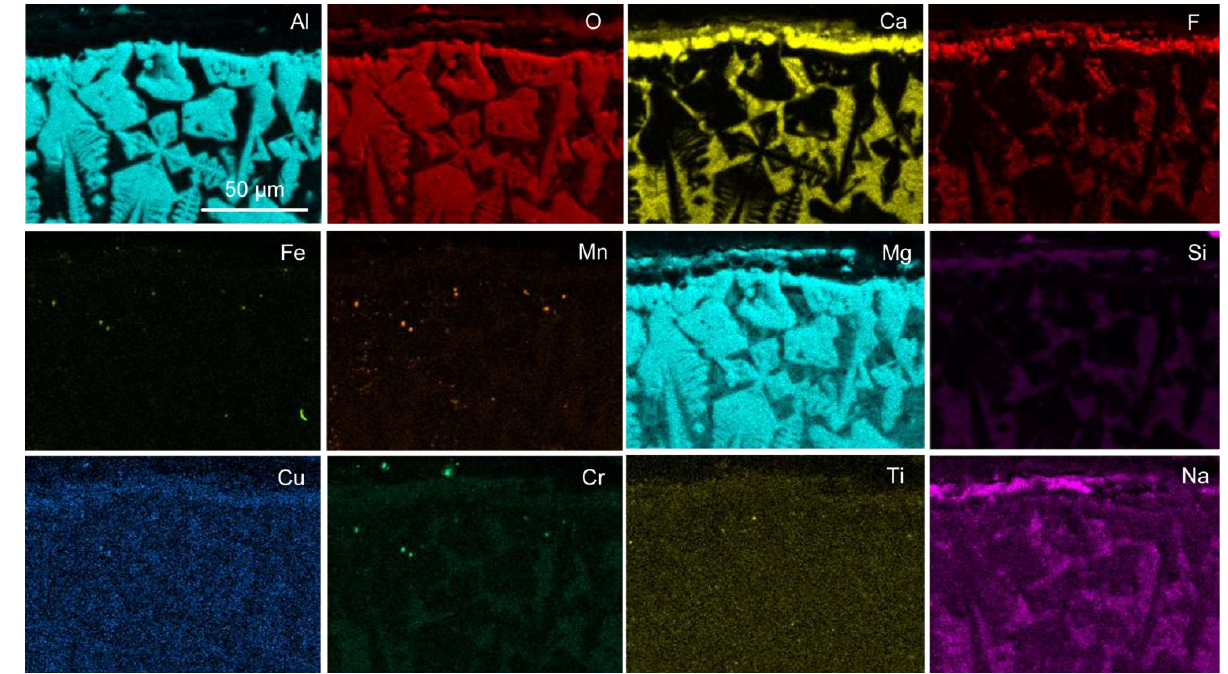
Figure 15. EDX map sample area in Figure 13b: MP4 slag sample.